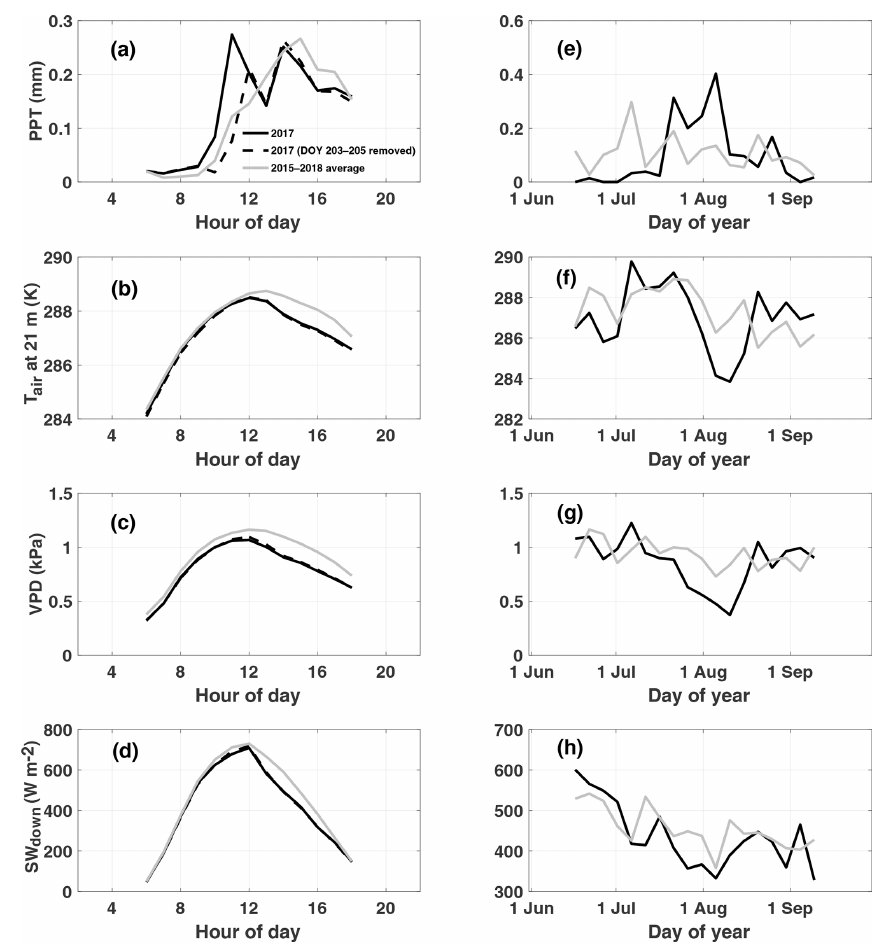
Figure 1. Observed diurnal (a–d) and synoptic (e–h) precipitation (PPT), air temperature at 21m ( T air ), vapor pressure deficit (VPD), and downwelling shortwave (SW down ) radiation. Diurnal cycles are averaged over July–August 2017. Synoptic cycles are plotted as 5d averages from 15 June to 15 September. Data from 2017 are shown in black, and climatology (2015–2018) is shown in grey. Typically, peak rainfall occurs in the afternoon at this site (a) . A substantial rain event which occurred from DOY (day of year) 203 to 205 is removed from the 2017 average to show the impact on diurnal variability and to demonstrate the dominance of the afternoon monsoon upon diurnal precipitation in